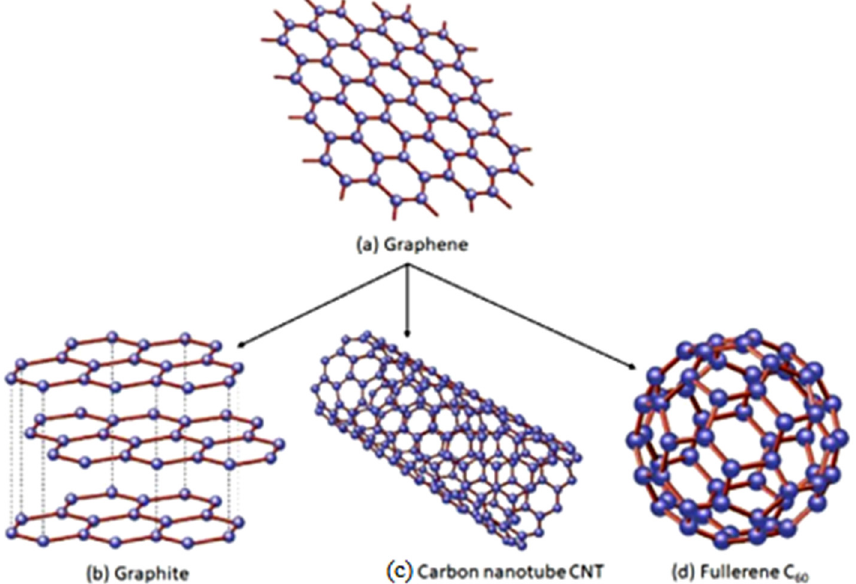
Figure 2. The Fundamental structure of Graphene. “Reproduced with permission from [19], [Materialia]; published by Elsevier, 2020”.